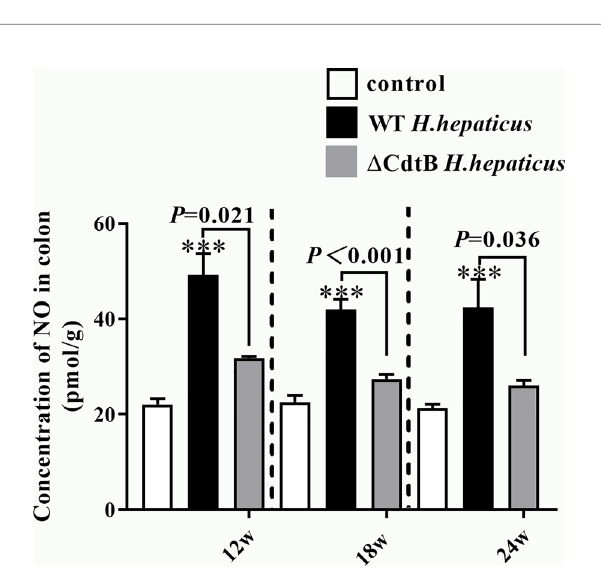
FIGURE 5 | H. hepaticus infection induced the protein expression of Il-6 in proximal colon. The cytokine levels of proximal colon tissue were expressed as the concentration in pg/g. Data are expressed as the means ± SEM (n = 5/group). *refers to the P value when compared with the control group, *for P < 0.05, **for P < 0.01.